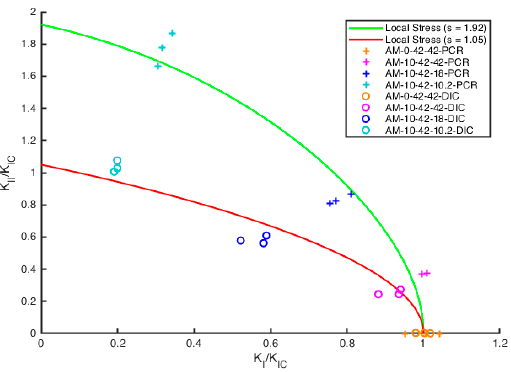
Figure 8. Fitting of the local stress criterium on the experimental data of the AM